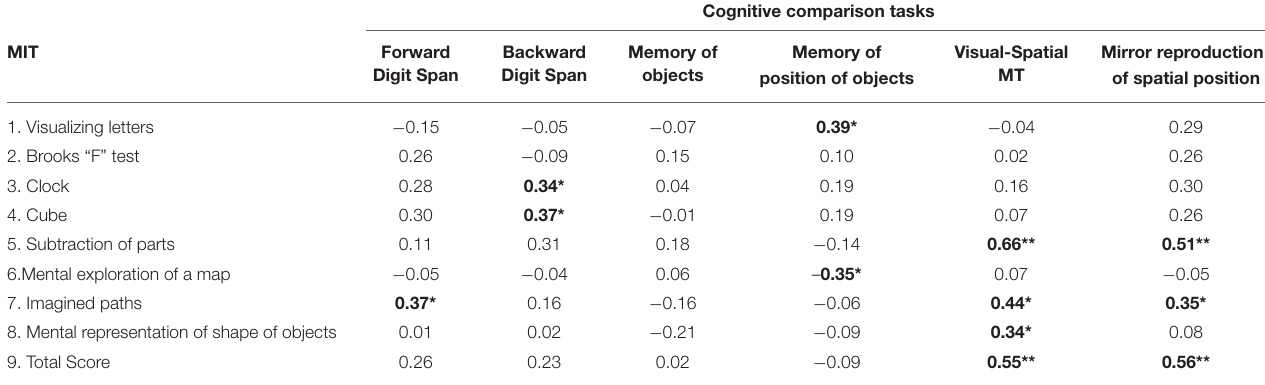
TABLE 4 | Correlations among MIT and Comparison tasks.